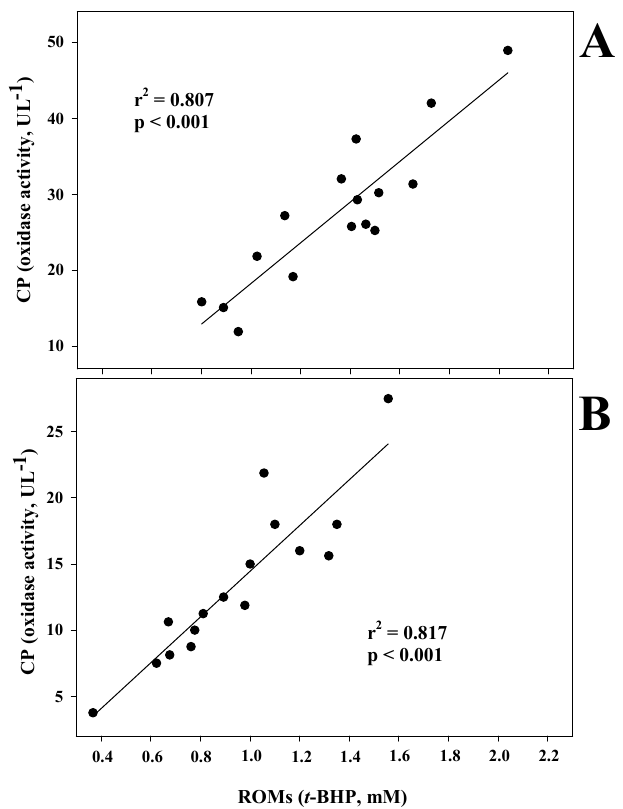
Figure 1. Regression analysis between reactive oxygen metabolites (ROMs) and ceruloplasmin (CP) oxidase activity in the blood serum of goat kids ( A ) and lambs ( B ). The poor agreement between these two different assays, both measuring LOOH con ‐ tent, was assessed using the Bland–Altman plot, which shows that the difference between the two methods tends to become larger as the values increase (Figure 2). In addition, all differences, except one, fell within the limits of agreement (mean ± 1.96 standard devia ‐ tion).